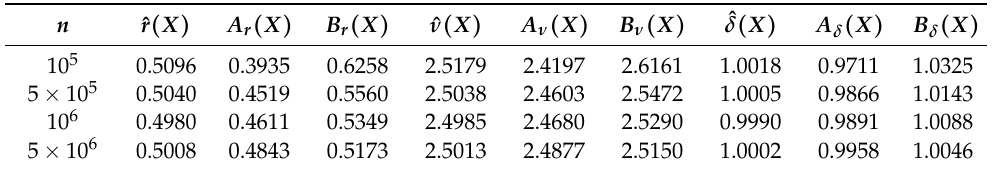
Table 2. Examples of estimates for the parameters and boundaries of confidence intervals for a model